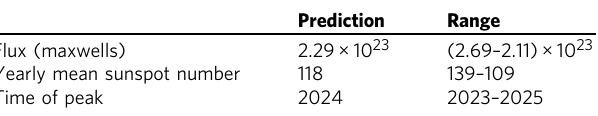
Table 1 Amplitude and timing of the maximum of solar